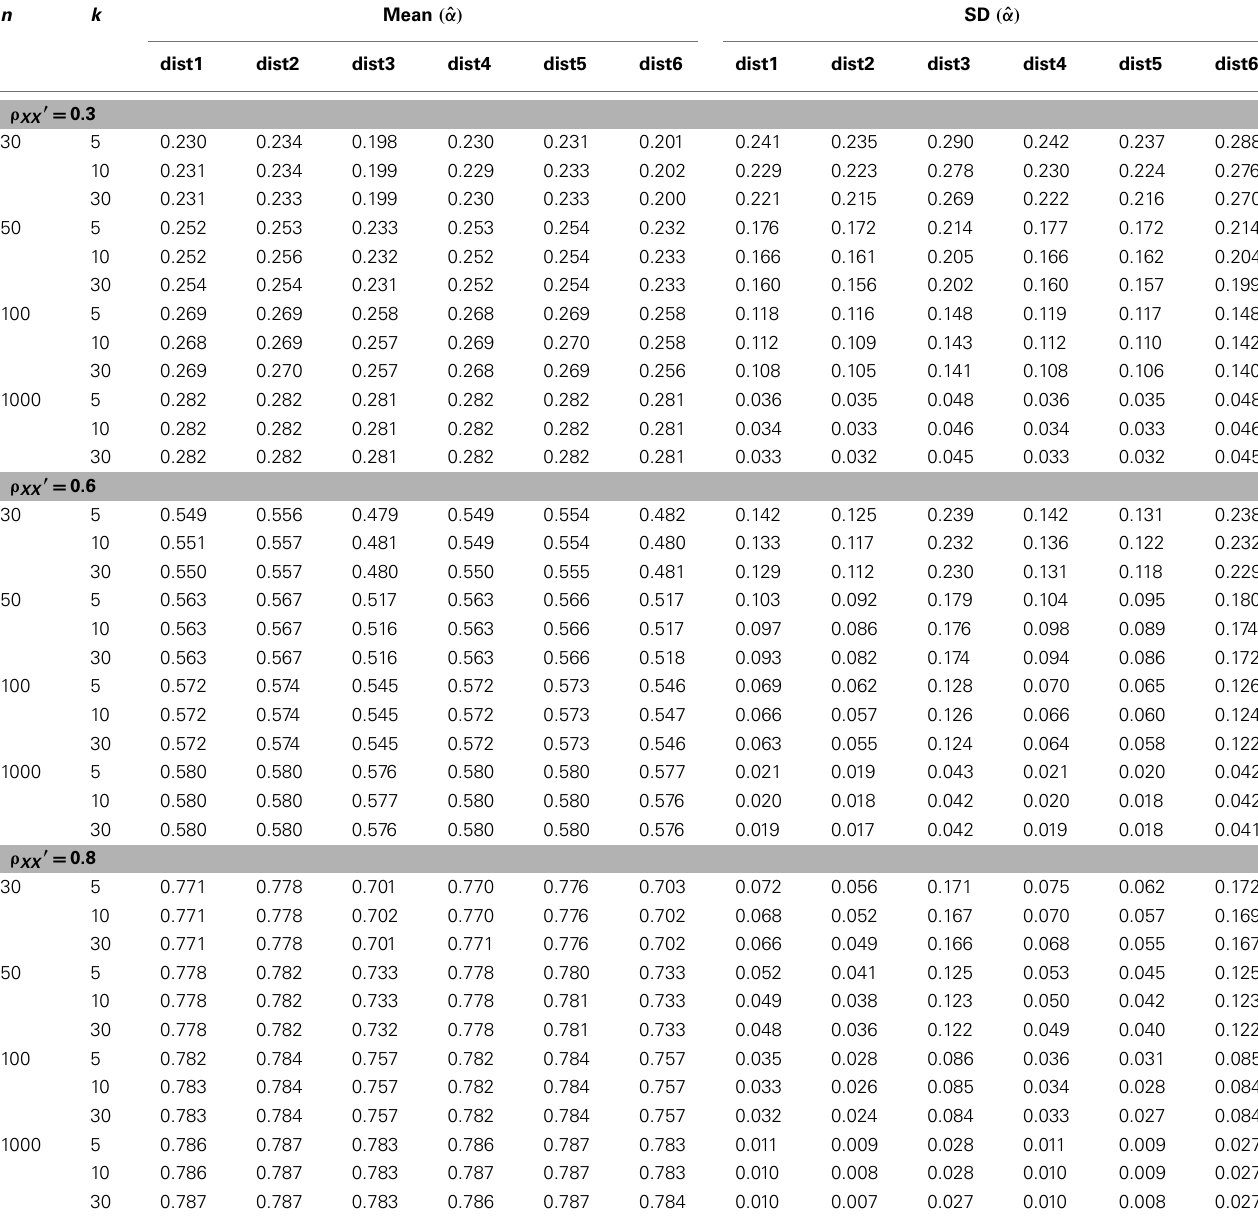
Table 1 | Observed mean and SD of the sample alpha ( ˆ α ) for the simulated situations where the true score ( t i ) distribution is normal or